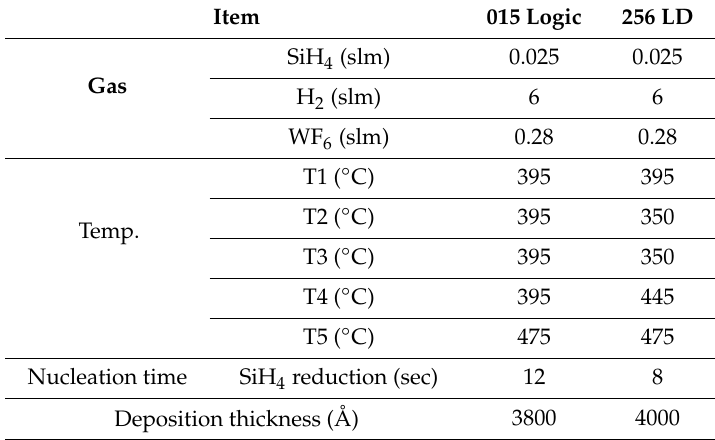
Table 4. Tungsten (W) deposition conditions.